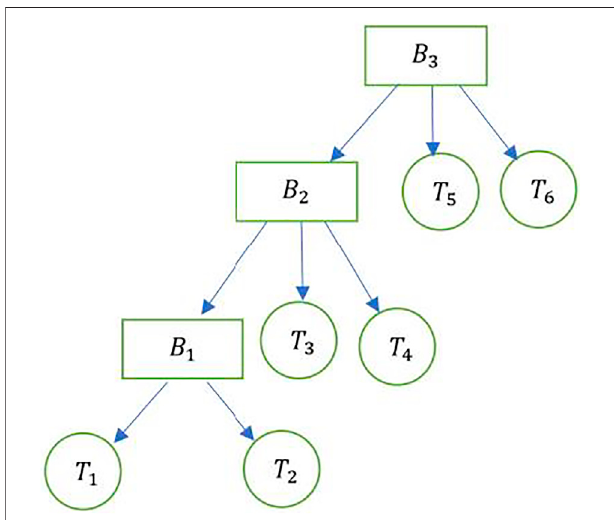
FIGURE 9 | Representing blocks, transactions and hashes as a